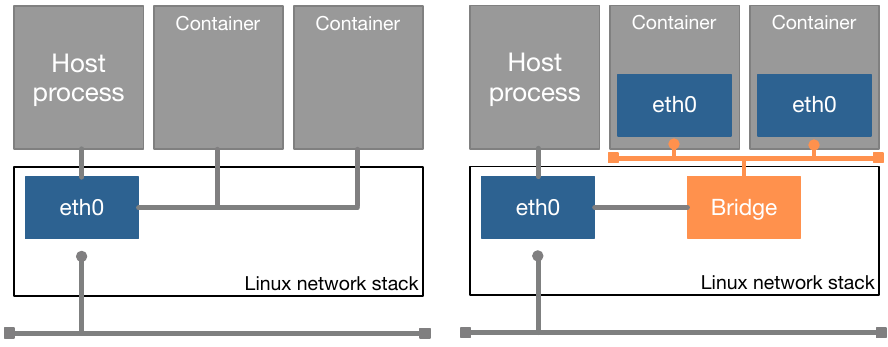
Figure 2. Architecture of the host driver mode ( left ) and the bridge driver mode ( right ).